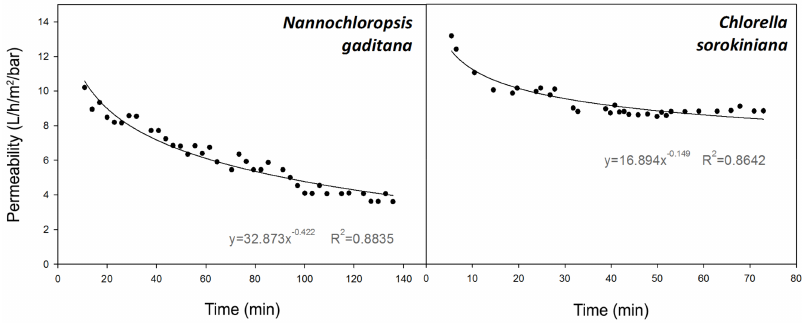
Figure 4. Permeability profiles vs. time of filtration experiments performed with ( a ) Nannochloropsis gaditana and ( b ) Chlorella sorokiniana